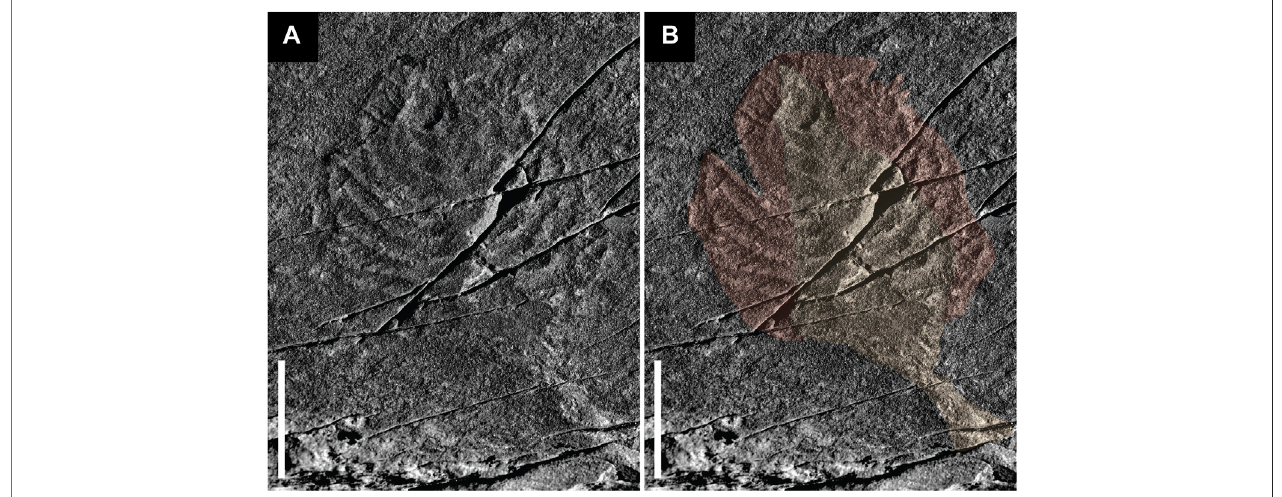
FIGURE7| Charniodiscussp .fromtheMistakenPointFormation( “ D ” -surface)atMistakenPoint,Newfoundland. (A) fi eldphotographyofthespecimen. (B) Stem and fl at basal section of the branches meeting the central axis at ∼ 90 ° in orange; apical section of the branches showing pronounced curvature in red. Scale bars 3 cm. Field photography. Not retrodeformed.